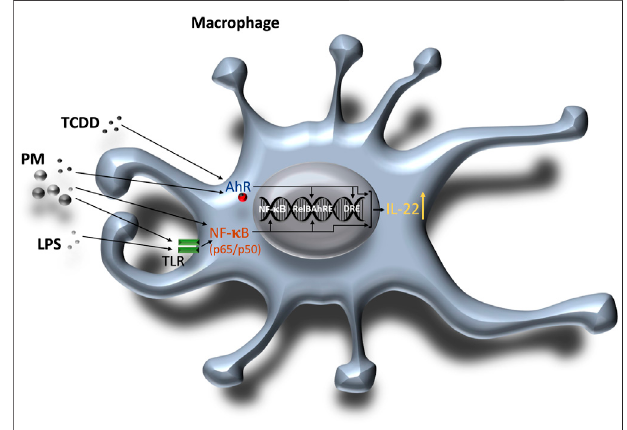
FIGURE 8 | Schematic illustration of the combinatorial regulation of mouseIL-22 via AhRandTLR/NF- κ Binmacrophages.1)AhRligandssuchas TCDD or PM containing PAHs activate the AhR signaling pathway and enhance DNA binding of AhR and RelB on the IL-22 promoter. PM derived from various sources like traf fi c emissions, combustion or wild fi res may also contain components such as endotoxin or metals which activate TLR and NF- κ B. 2) TLR ligands including LPS bind to TLR and activate NF- κ B (p65/p50)inducing DNAbindingactivity ofNF- κ BandRelB.Activation ofboth AhR and NF- κ B signaling leads to a synergistic induction of IL-22.